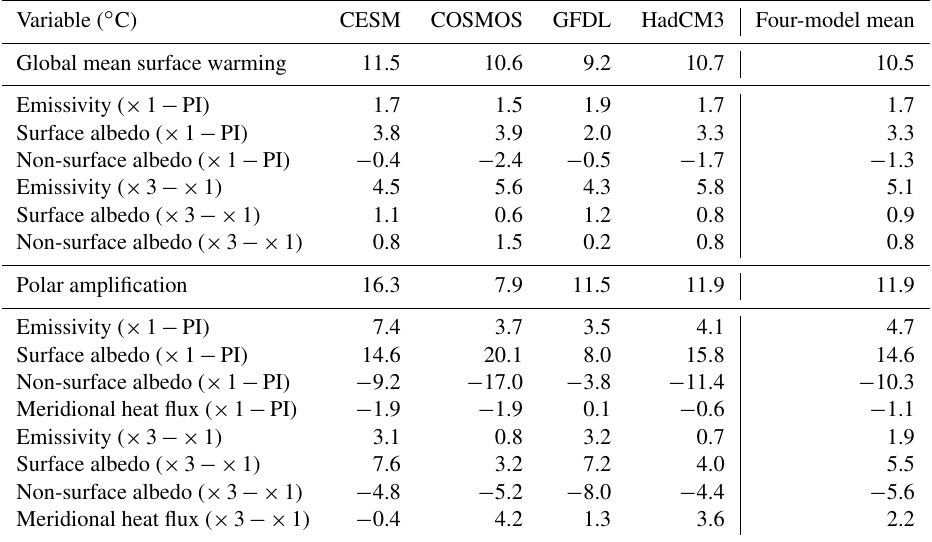
Table 2. Summary of the contributions to global mean surface warming and polar amplification from preindustrial to × 3. Values are shown for the four DeepMIP models that carried out simulations of the preindustrial, × 1, and × 3 (CESM, COSMOS, GFDL, and HadCM3). The values correspond to those shown in Figs. S5 and S6. Note that the sum of these is slightly different from the values in Fig. 4 due to non-linearities. Polar amplification is defined as the difference in warming between the high latitudes (polewards of ± 60 ◦ ) and the tropics ( ± 30 ◦